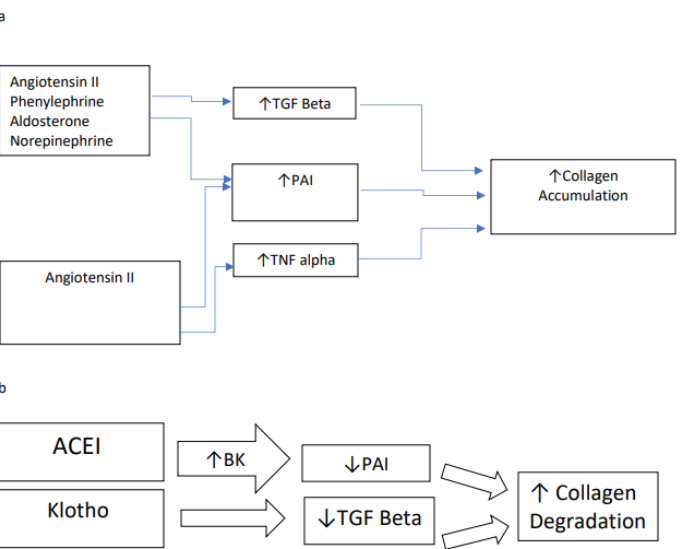
Figure 1. Metabolism of Collagen. ACE-I angiotensin converting enzyme inhibitor; BK bradykinin; PAI plasminogen activator inhibitor; TGF beta transforming growth factor beta; TNF alpha tissue necrosis factor alpha. Table 4. Increased Expression of Plasminogen Activator Inhibitor.